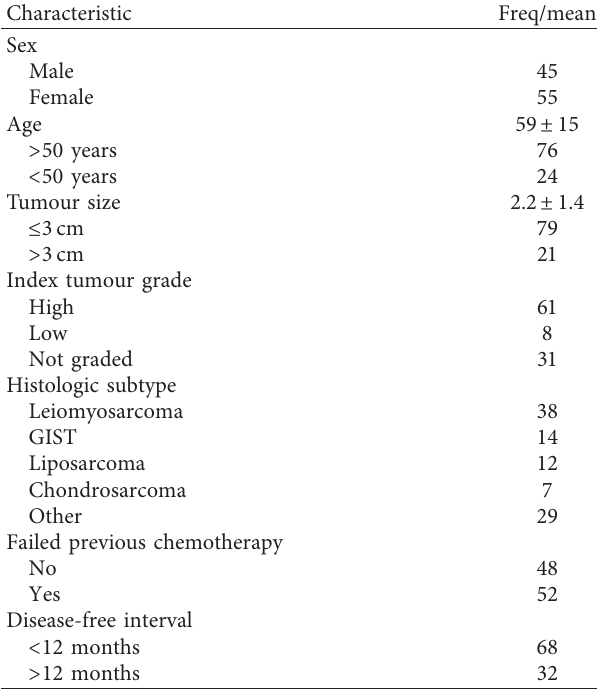
Table 1: Demographics and clinical